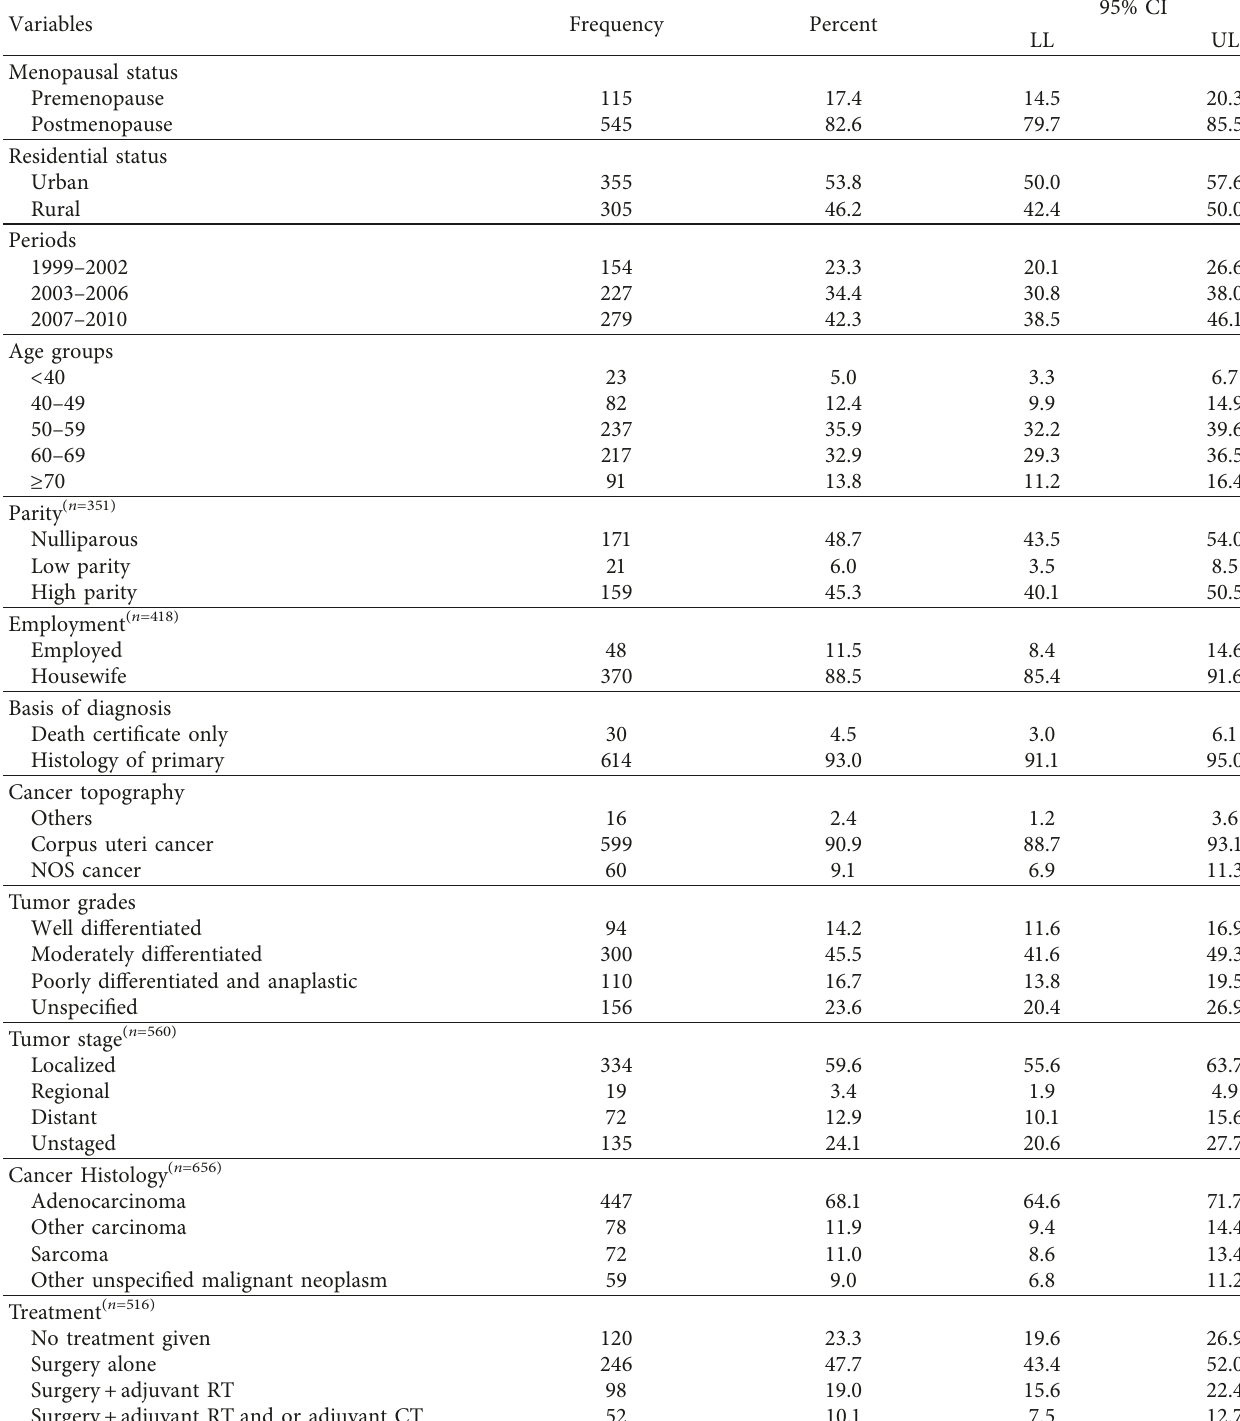
Table 1: Demographic and clinical characteristics of 660 uterine cancer patients in the Gharbiah province between 1999 and